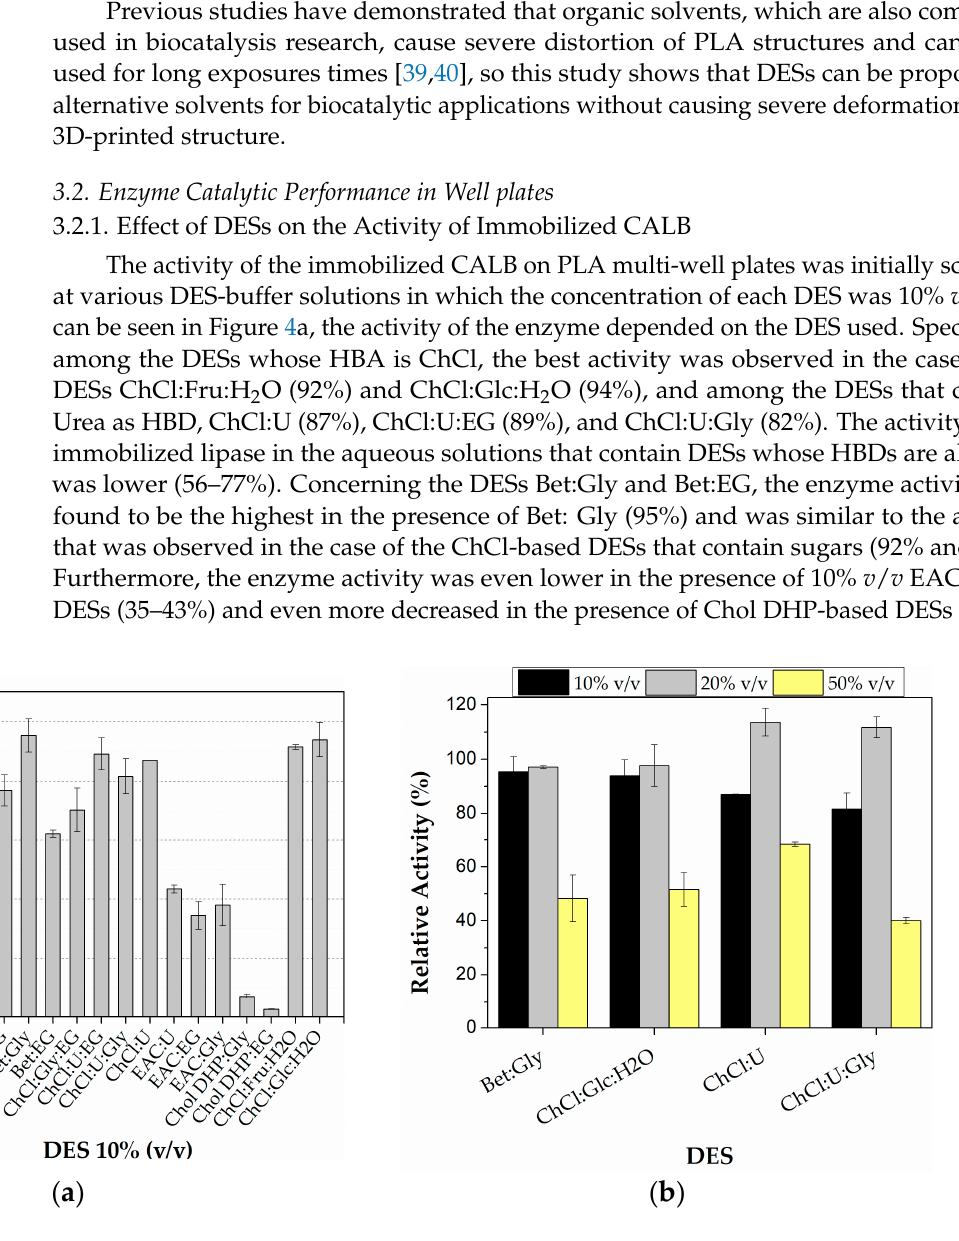
Figure 4. Relative activity of immobilized CALB on PLA well plates ( a ) in various 10% v / v DES:buffer solutions and ( b ) in increased concentrations of certain ones. 100% is defined as the activity of the immobilized enzyme in buffer (0% v / v DES). Reaction conditions: 0.25 mM pNPB in 50 mM phosphate buffer pH 7.5, 10, 20, or 50% v / v DESs, 40 °C, reaction time 5 min.